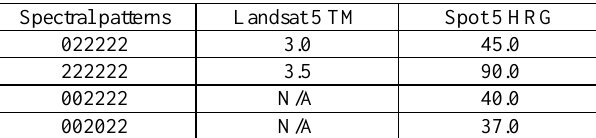
Table 3. Threshold values for spectral patterns in Landsat 5 TM